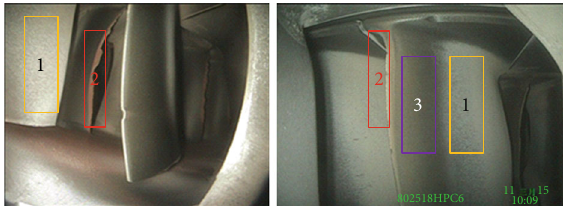
Figure 9: Dirt classi fi